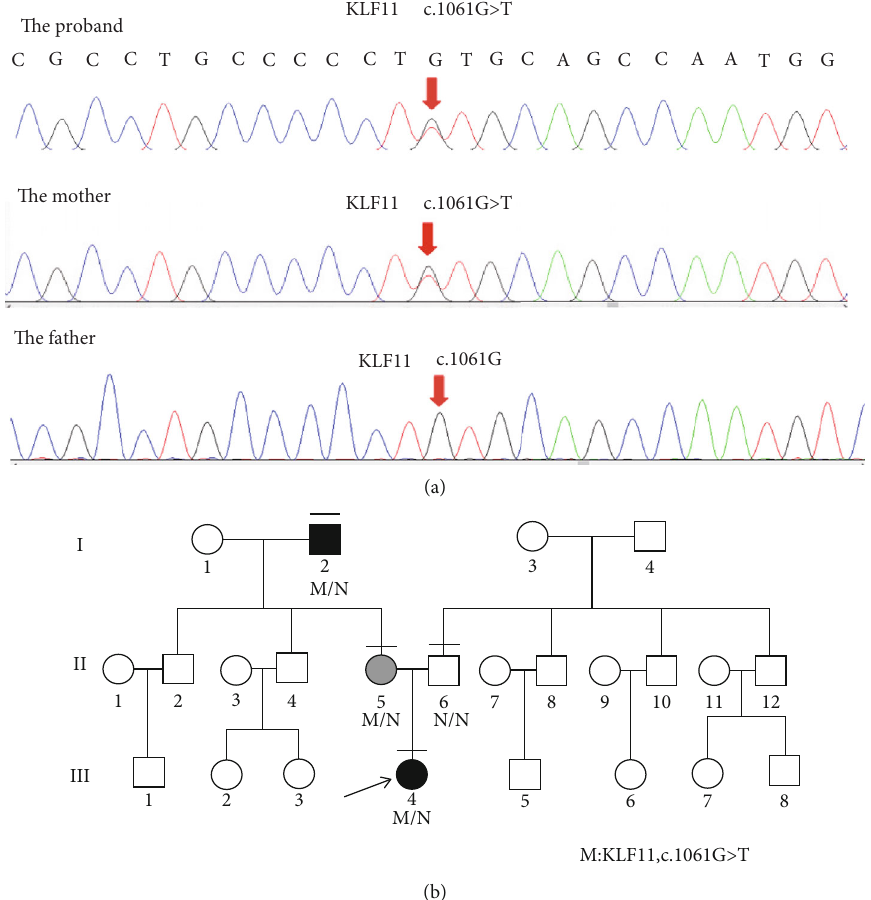
Figure 1: Partial sequence diagram of KLF11 and the pedigree of the studied family members. (a) Partial sequence diagram of KLF11 . A heterozygous c.1061G > T transition mutation, causing the substitution of cysteine by phenylalanine at codon 354 is shown using an arrow (GenBank accession number: NM_003597.4). (b) The pedigree of the study family. Women are represented using circles and men, using squares. The black symbols indicate individuals with diabetes. The grey symbol indicates individuals with prediabetes. The proband is denoted by an arrow. The horizontal lines indicate individuals who underwent molecular analysis. The p.Cys354Phe variant of KLF11 was identi fi ed in I-2, II-5, and III-4. The N symbols denote the people that carry the WT gene, and the M symbols denote the people that carry the Cys354Phe